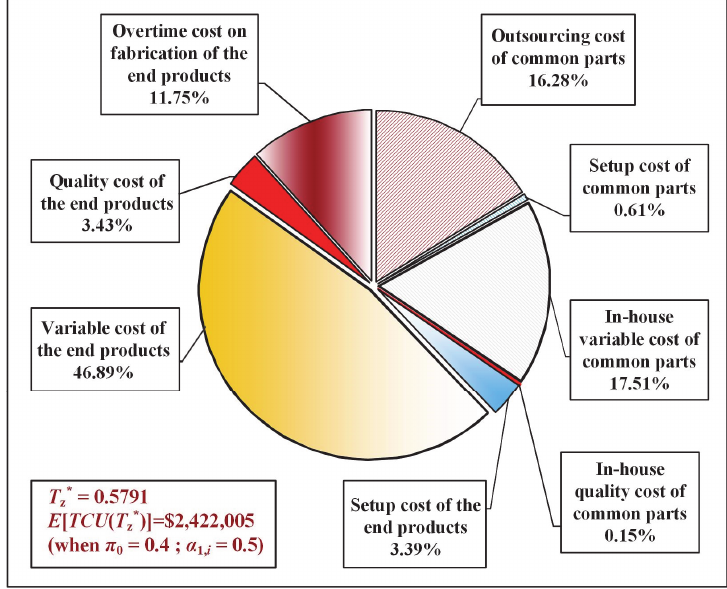
Fig. 17. The breakup of E [ TCU ( T Z*